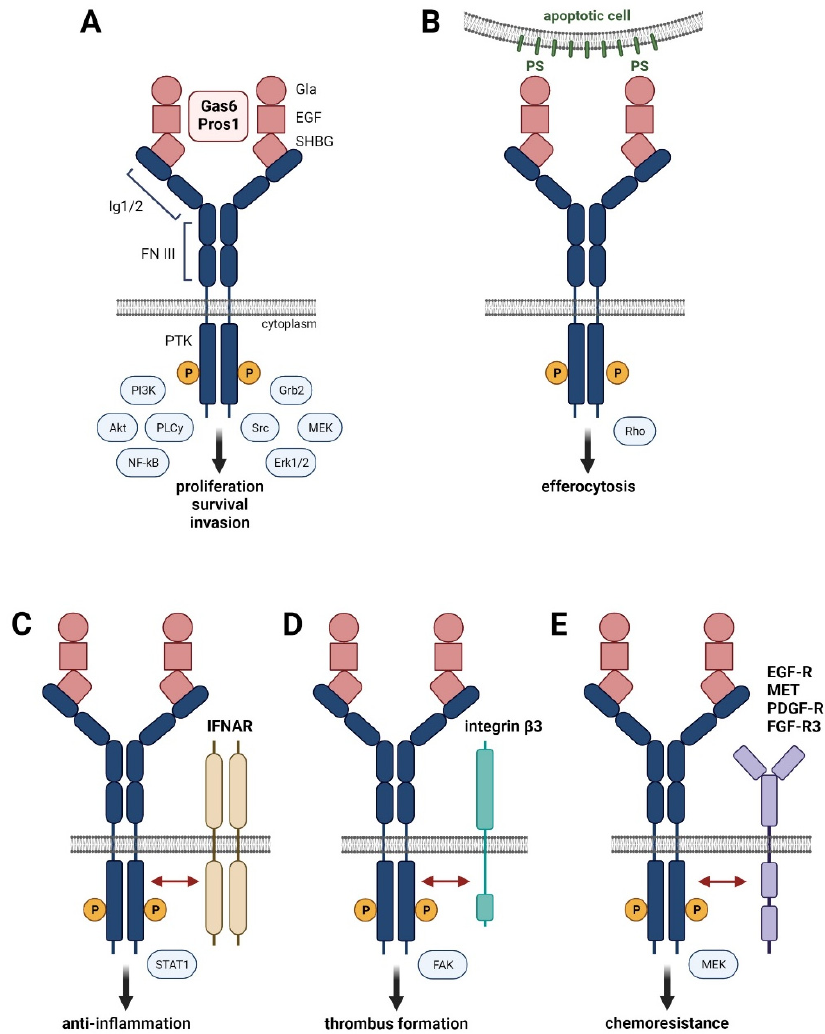
Figure 1. Hallmarks of Gas6-Pros1/TAM signaling. ( A ) Binding of high affinity ligands Gas6 or Pros1 to the immunoglobulin (Ig) domains of TAM receptors causes homo-dimerization and activation by phosphorylation of the intracellular protein kinase domain (PTK). ( B ) Interaction of Gas6 or Pros1 with TAM receptors and phosphatidylserine residues (PS) promotes phagocytosis of apoptotic cells. ( C – E ) Interaction of activated TAM receptors with interferon- α / β receptor (IFNAR) ( C ), integrin β 3 ( D ), and the RTKs EGF-R, MET, PDGF-R, or FGFR-3 ( E